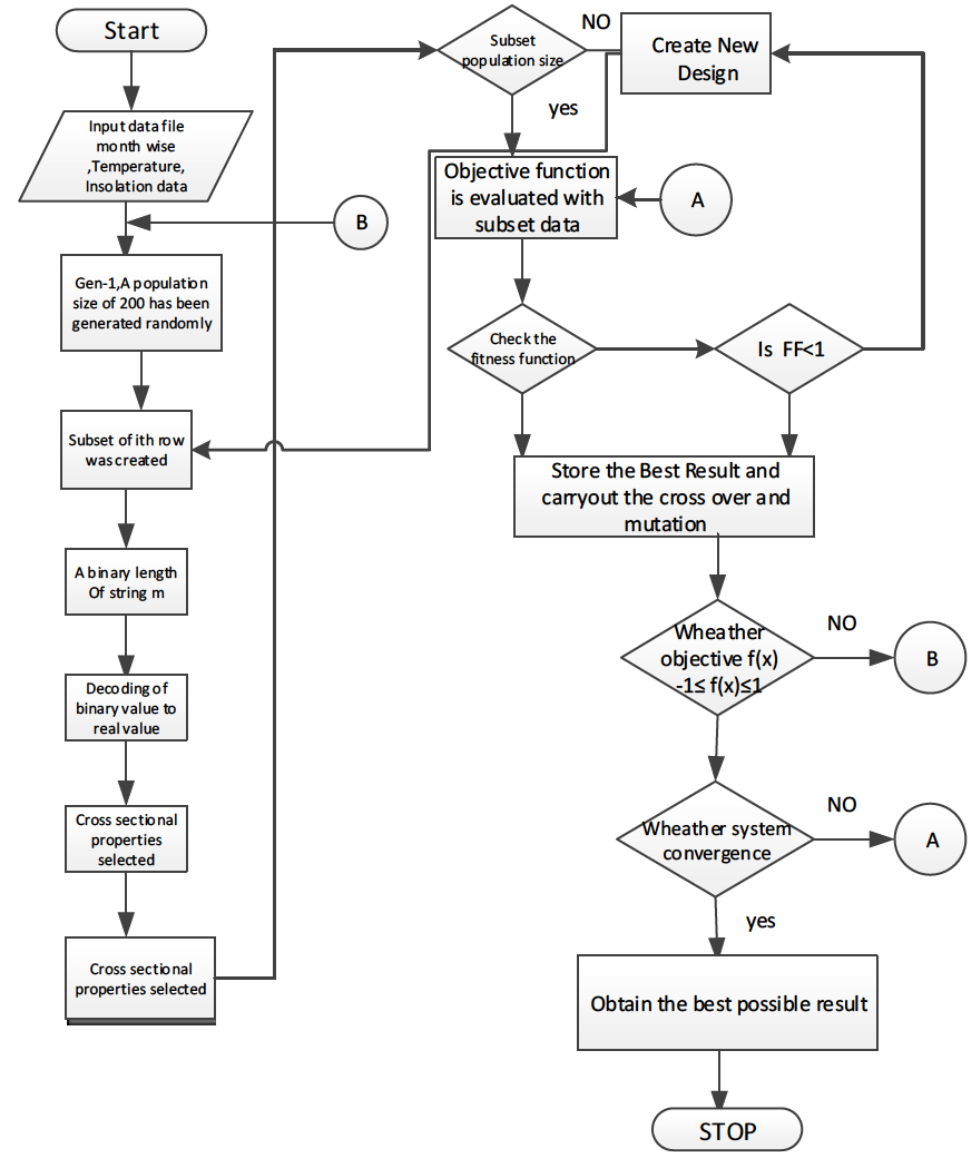
Figure 1: Algorithm of the Proposed GA Technique for Forecasting of Solar PV AC output